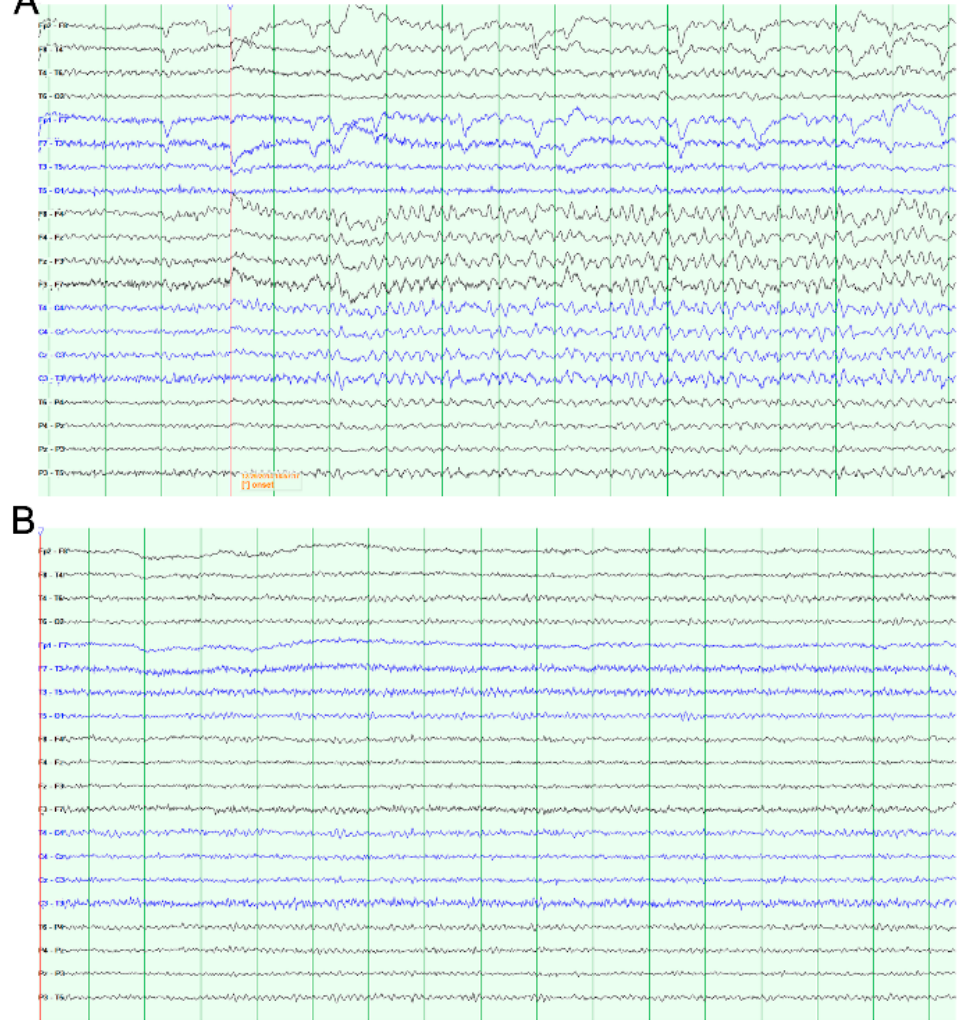
Figure 1. Example EEG recordings from patient 1. ( A ) Ictal EEG showing rhythmical, symmetrical 6 Hz theta slow wave activity across the frontocentral regions. ( B ) EEG showing normal background activity.